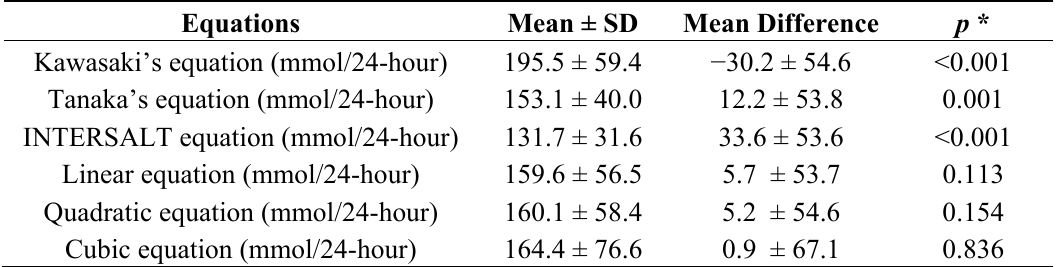
Table 2. Calculated 24-hour urine sodium excretion obtained by six